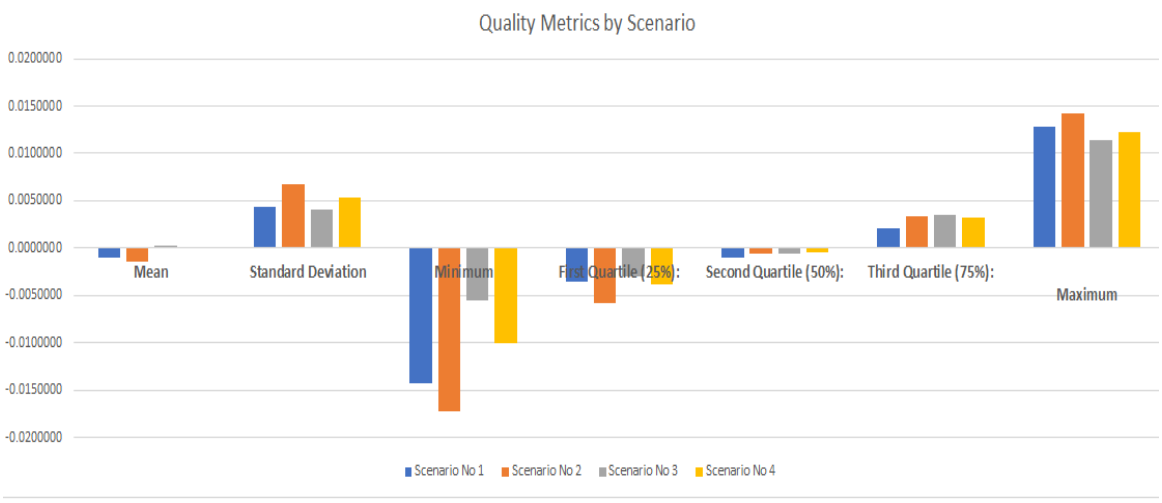
Figure 9. Quality metrics by scenario.